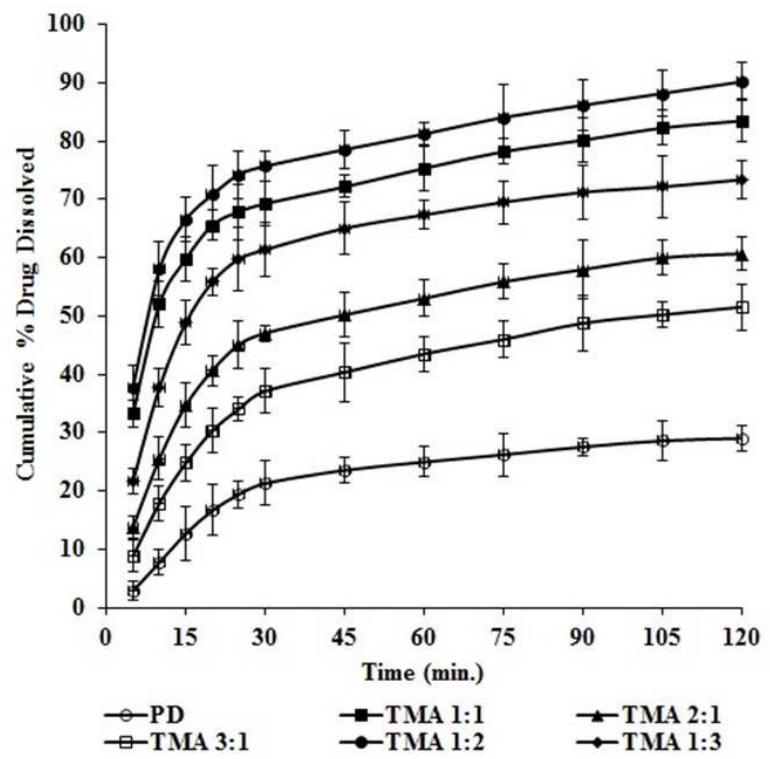
Figure 7. In vitro dissolution study of telmisartan (PD) and telmisartan-maleic acid